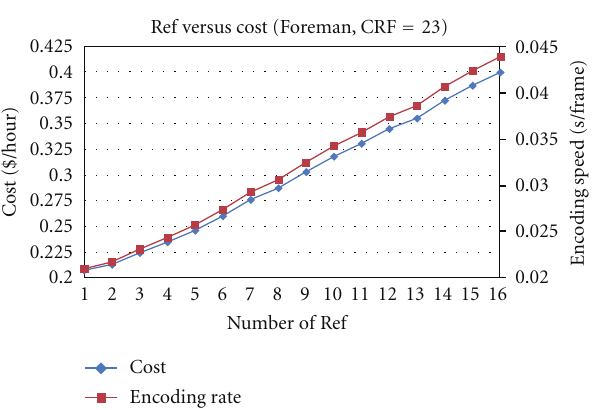
Ref versus cost (Foreman, CRF = 23)